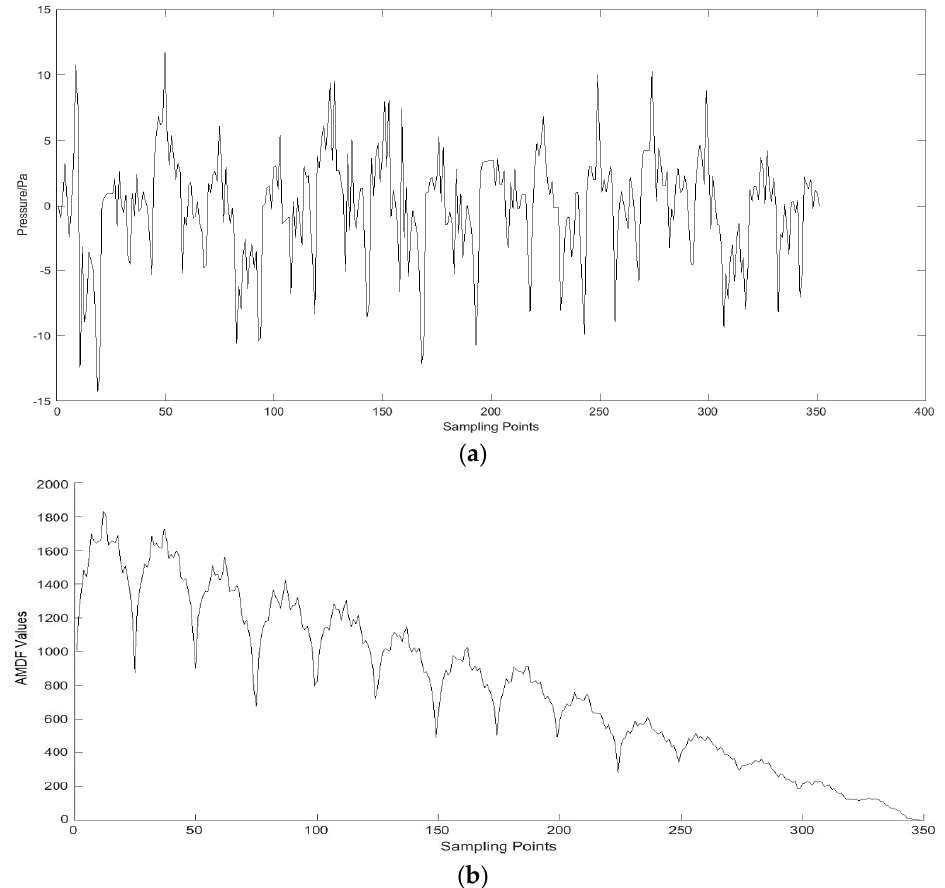
Figure 5. Simulation results of the traditional AMDF algorithm: ( a ) The original signal; ( b ) The traditional AMDF result.